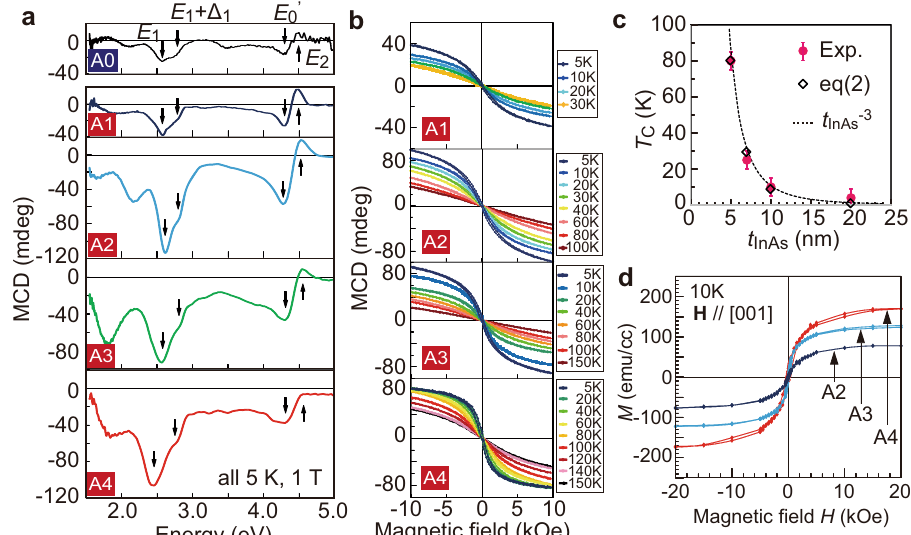
Fig. 2 Magnetic properties of the FeAs/InAs SLs. a MCD spectra of sample A1 – A4, compared with that of a reference sample (A0) of 12 nm-thick (In 0.94 , Fe 0.06 )As. All spectra were measured at 5 K and 1 T. b Magnetic fi eld dependence of MCD intensity (MCD – H curves) measured at E 1 in sample A1 – A4 at various temperatures. c Curie temperature ( T C ) as a function of the distance t InAs between the FeAs MLs (pink circles). The error bars of 5 K are also plotted, which correspond to the minimum temperature step in our MCD – H measurements. The relationship can be fi tted well by the T C ∝ t InAs − 3 curve (dotted curve). The T C values calculated using Eq. (2) with A = 250 (open diamonds) also well reproduce the experimental results. d Magnetic fi eld dependence of magnetization in sample A2 – A4, measured by SQUID magnetometry at 10 K, under a magnetic fi eld perpendicular to the fi lm